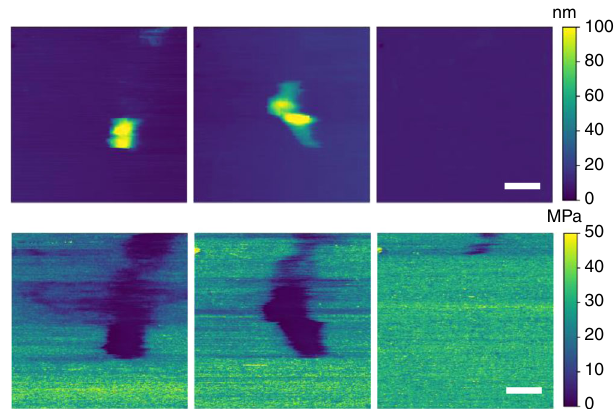
Fig. 5 Surface measurements during cubosome uptake measured by liquid AFM. AFM sequence showing the variation in surface topology (upper) and Modulus (lower) as a cubosome interacted with SLB. Scale bar =